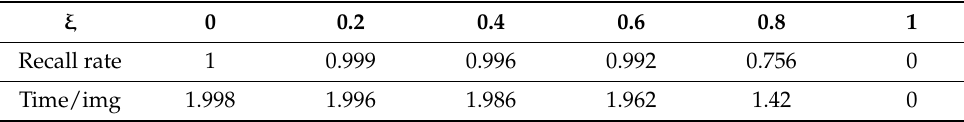
Table 1. The effect of threshold on algorithm performance.